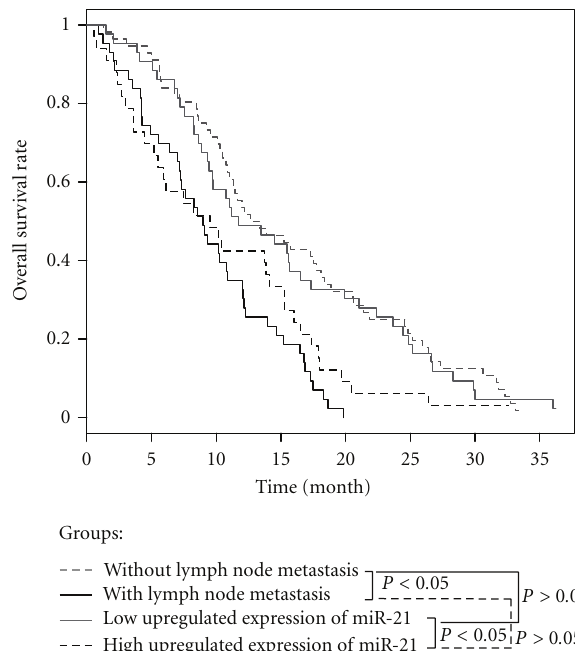
Figure 2: Kaplan-Meier survival curves of GC patients. The overall survival rate in patients with high miR-21 expression was significantly lower than that in those with low miR-21 expression ( P < 0 . 05).